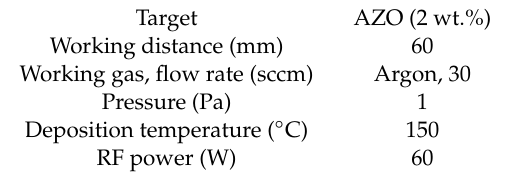
Table 1. Deposition conditions of aluminum oxide (2 wt.%)-doped ZnO (AZO) film.